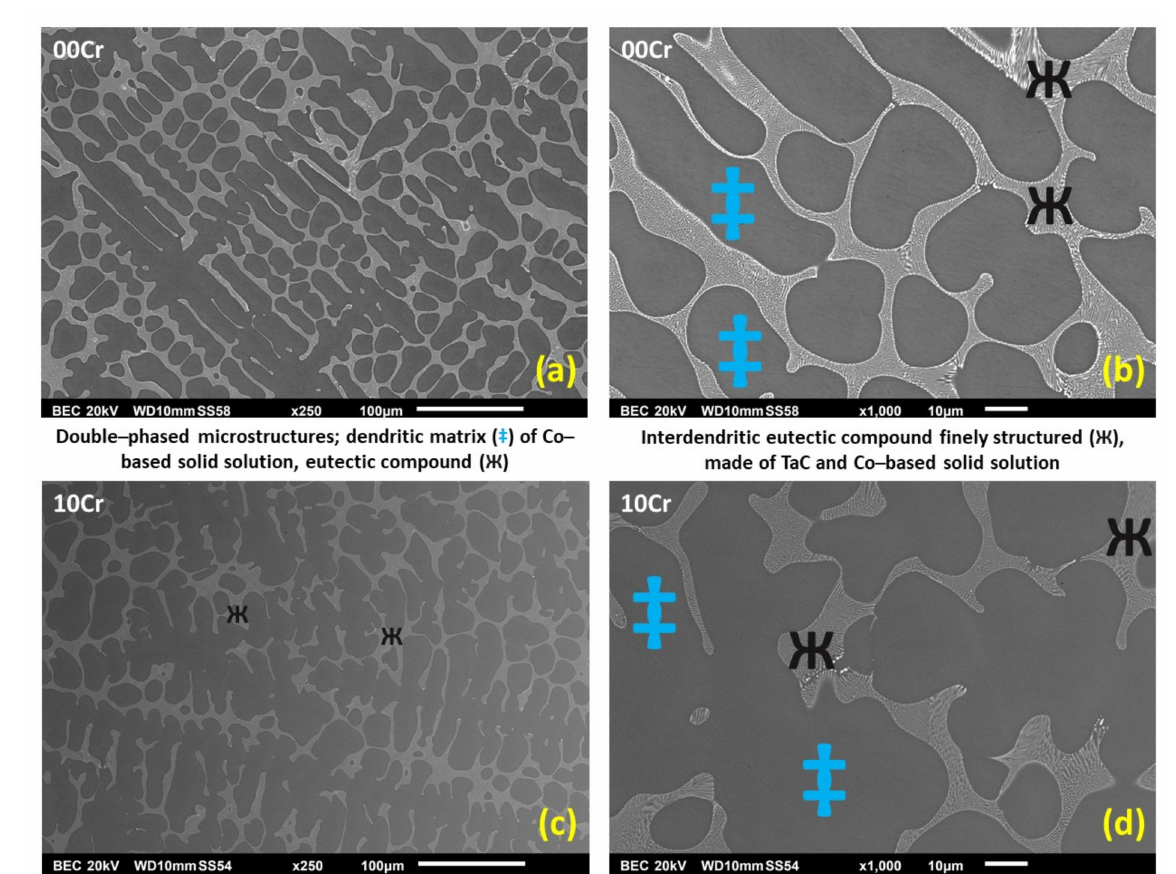
Figure 2. As-cast microstructures of the 00Cr ( a , b ) and 10Cr ( c , d ) alloys; general ( × 250: a , c ) and detailed ( × 1000: b , d )